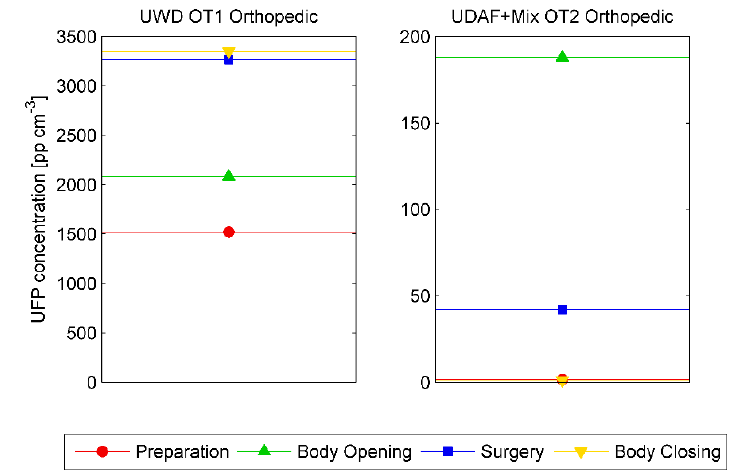
Figure 3. Time average UFPs concentration for UWD OT1 (left) and Hybrid OT2 (right) in orthopedic surgeries as function of surgery phases.